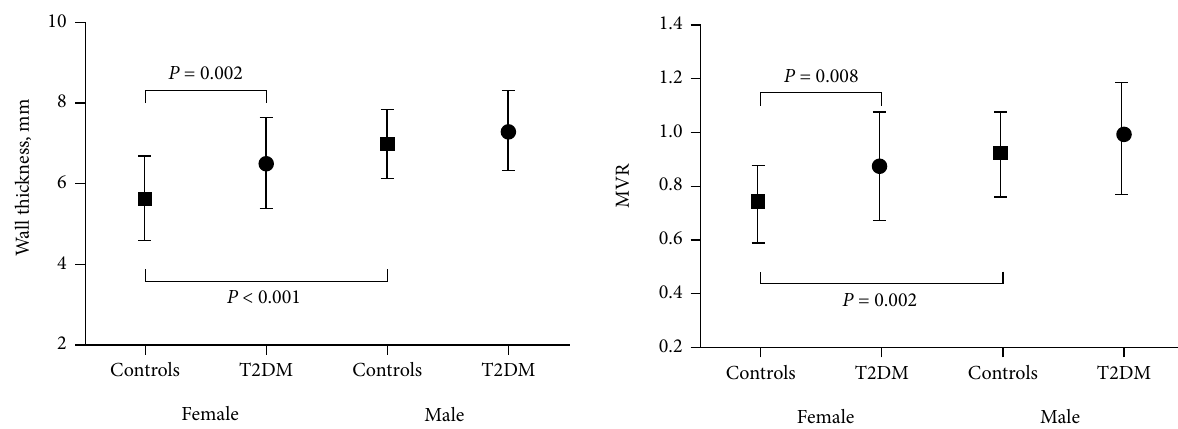
Figure 1: Sex di ff erences in myocardial structure between control and T2DM subjects. MVR: mass to end-diastolic volume ratio.